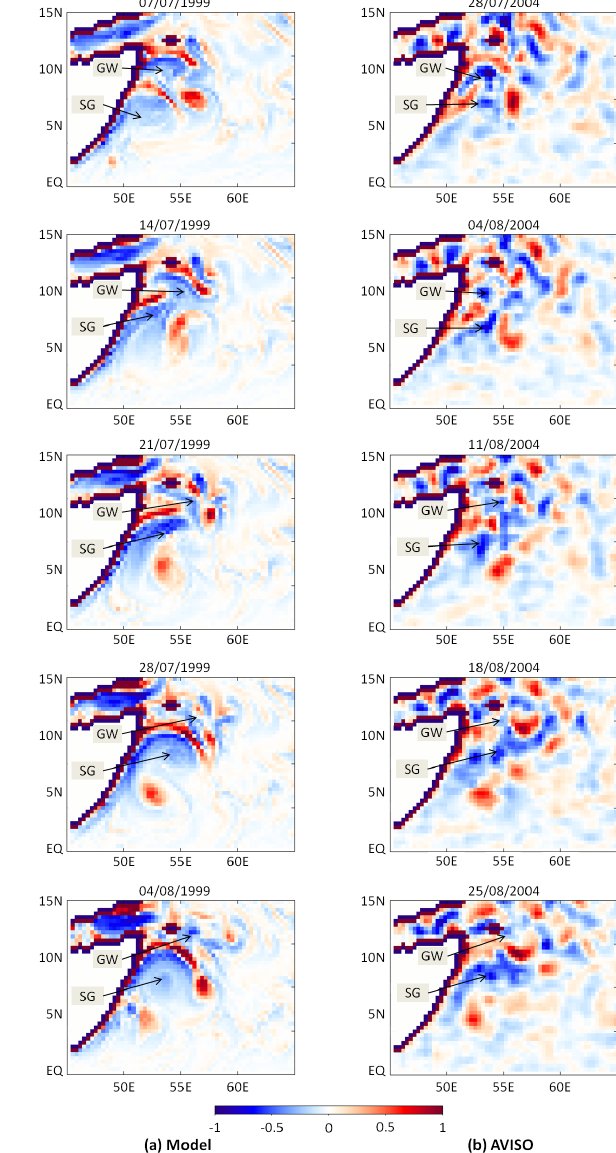
Figure 13. Sequences of SSH 7-day snapshots from (a) model sim- ulation S12-1 outputs co-localized in time and space onto the Aviso grid and (b) AVISO sea level anomalies (SLA) data combined with the mean SSH of Maximenko and Niiler (2005). Arrows indicate the location of the Southern Gyre (SG) and the Great Whirl (GW) determined in (a) using the vorticity and spiciness of the model at full resolution, and in (b) to suggest a possible collision scenario.